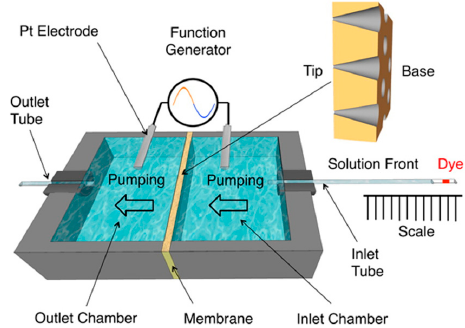
Figure 11. Schematic illustration of the alternating current (AC) EOF pump cell. A dye plug in the inlet tube was used to determine the EOF velocity. A net flow from base to tip (from right to left) was observed. Reproduced with permission from [33]. American Chemical Society,